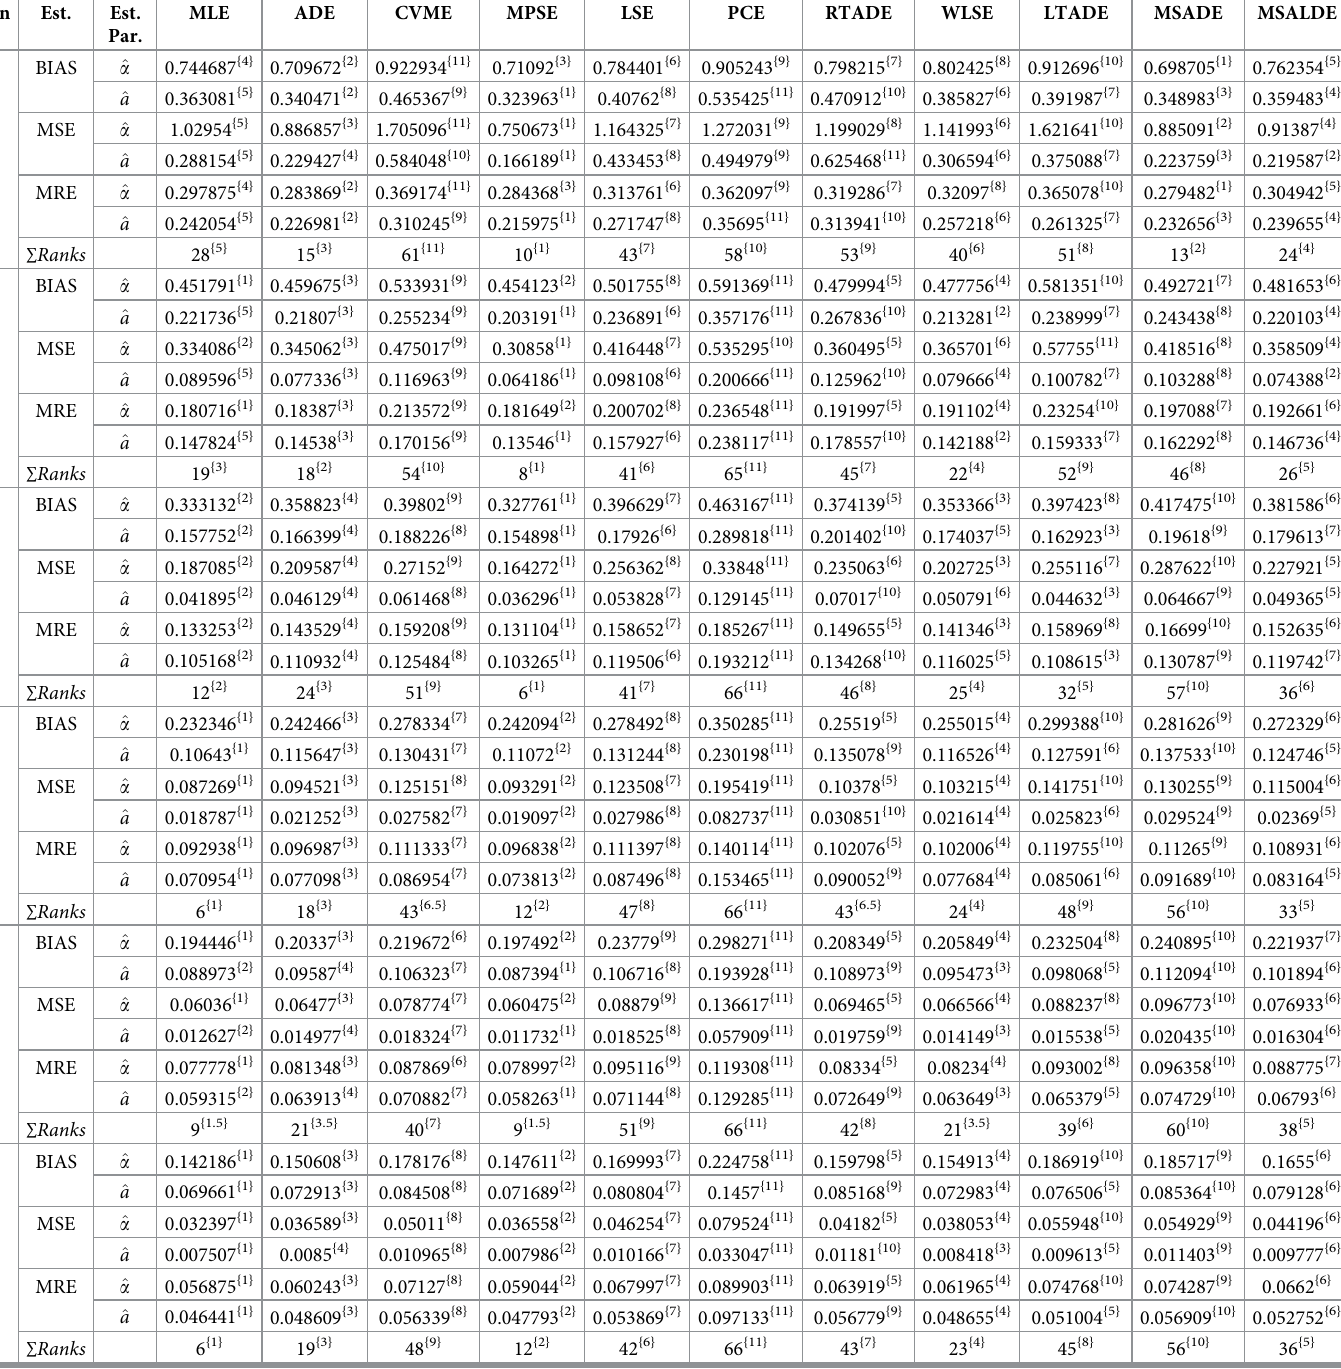
Table 3. Simulation values of BIAS, MSE and MRE for ( α = 2.5, a =